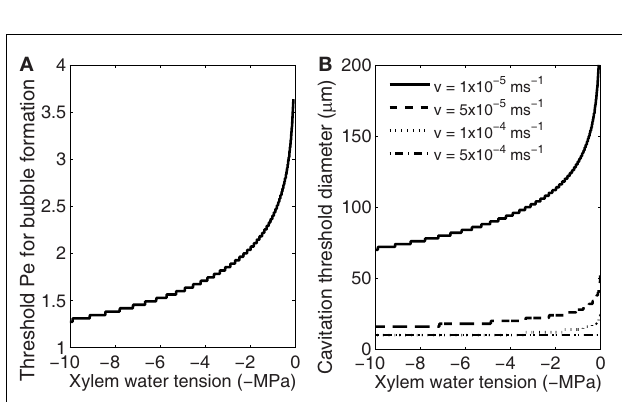
conduit size (Pe; see Figure 2 ). (B,C) Show that slightly higher concentrations are needed for bubble formation become likely in small than in large conduits (Eq. 9) and if the time allowed for nucleation to take place is short (high freezing velocity, see Eq. 18). Here the initial gas concentration was set to saturation and C ∗ values presented concentrations above saturation.